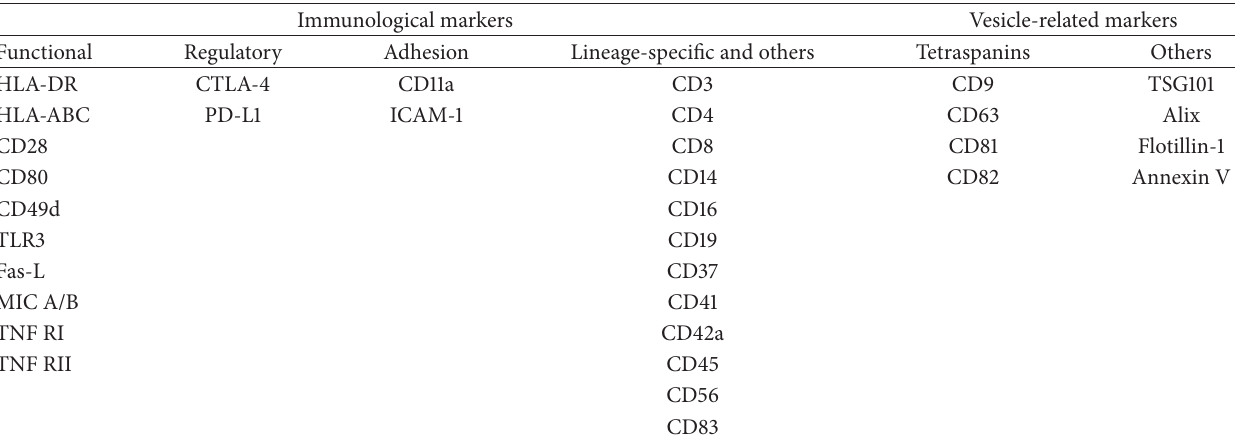
Table 1: Overview of the markers selected for phenotyping of